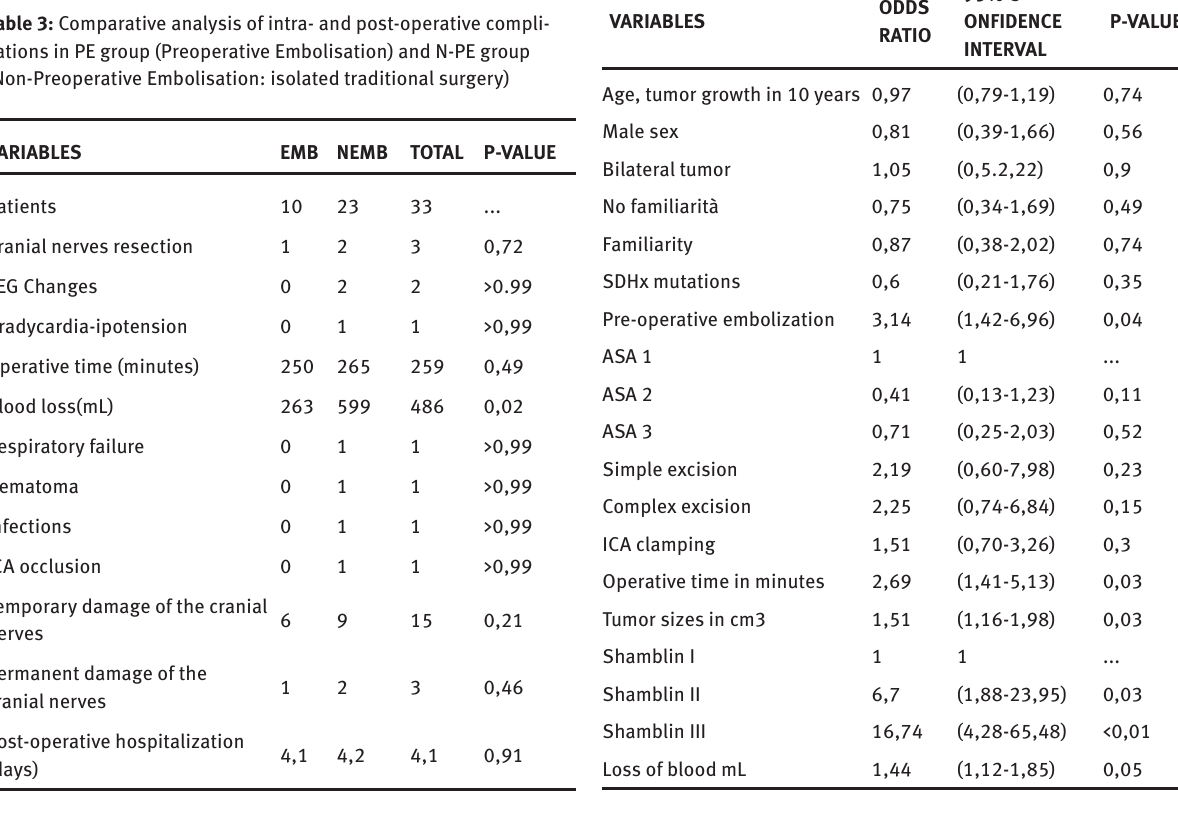
Table 3: Comparative analysis of intra- and post-operative compli- cations in PE group (Preoperative Embolisation) and N-PE group (Non-Preoperative Embolisation: isolated traditional surgery)